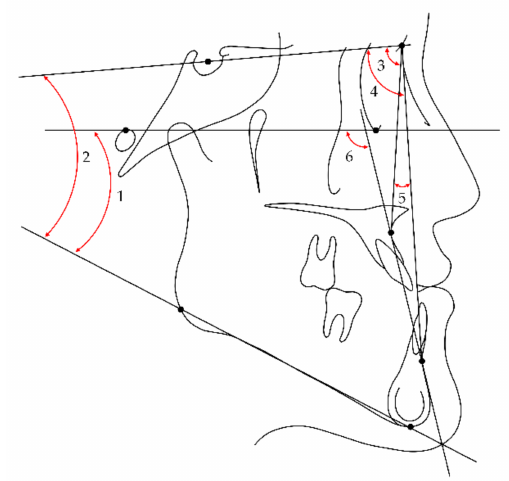
Figure 2. Skeletal cephalometric variables measured in this study (all variables were angular